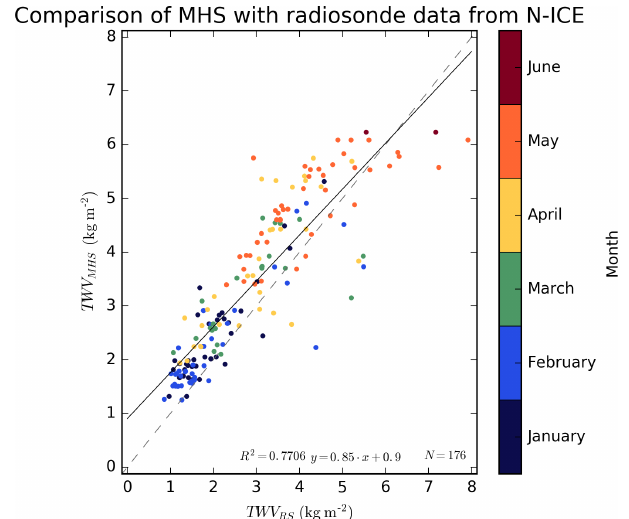
Figure 5. Scatter plot and fit for MHS TWV vs. radiosonde TWV retrievals for all coincident points during the N-ICE campaign. The colour scale shows the month where the data point comes from. The dashed line shows the one-to-one lines, and the solid line shows the linear regression.